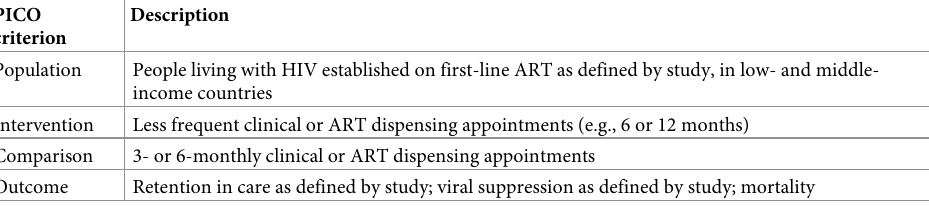
Table 1. Eligibility criteria for included